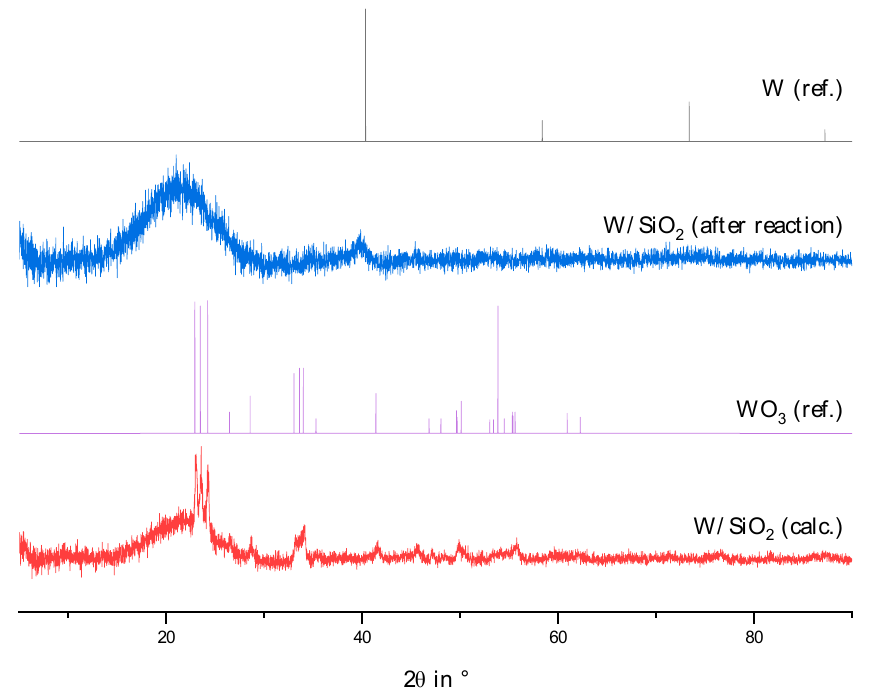
Figure A3. P-XRD of calcined tungsten catalyst before reaction (calc.) and after reaction.